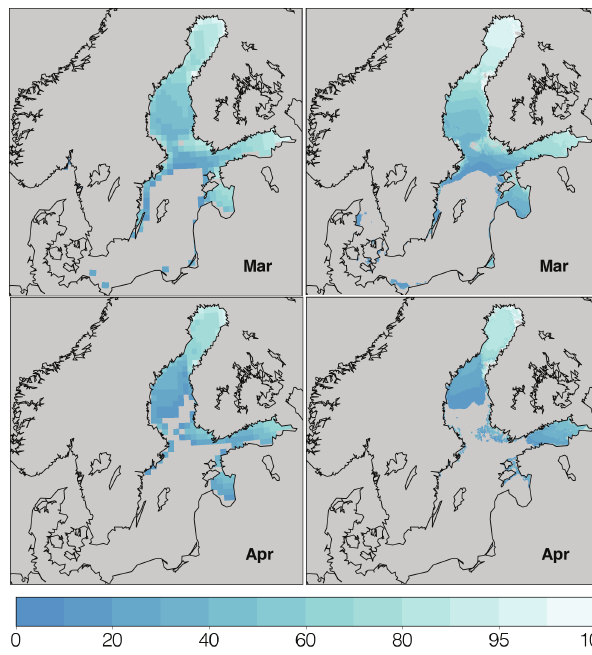
Figure 7. Same as Fig. 6 but for March and April.